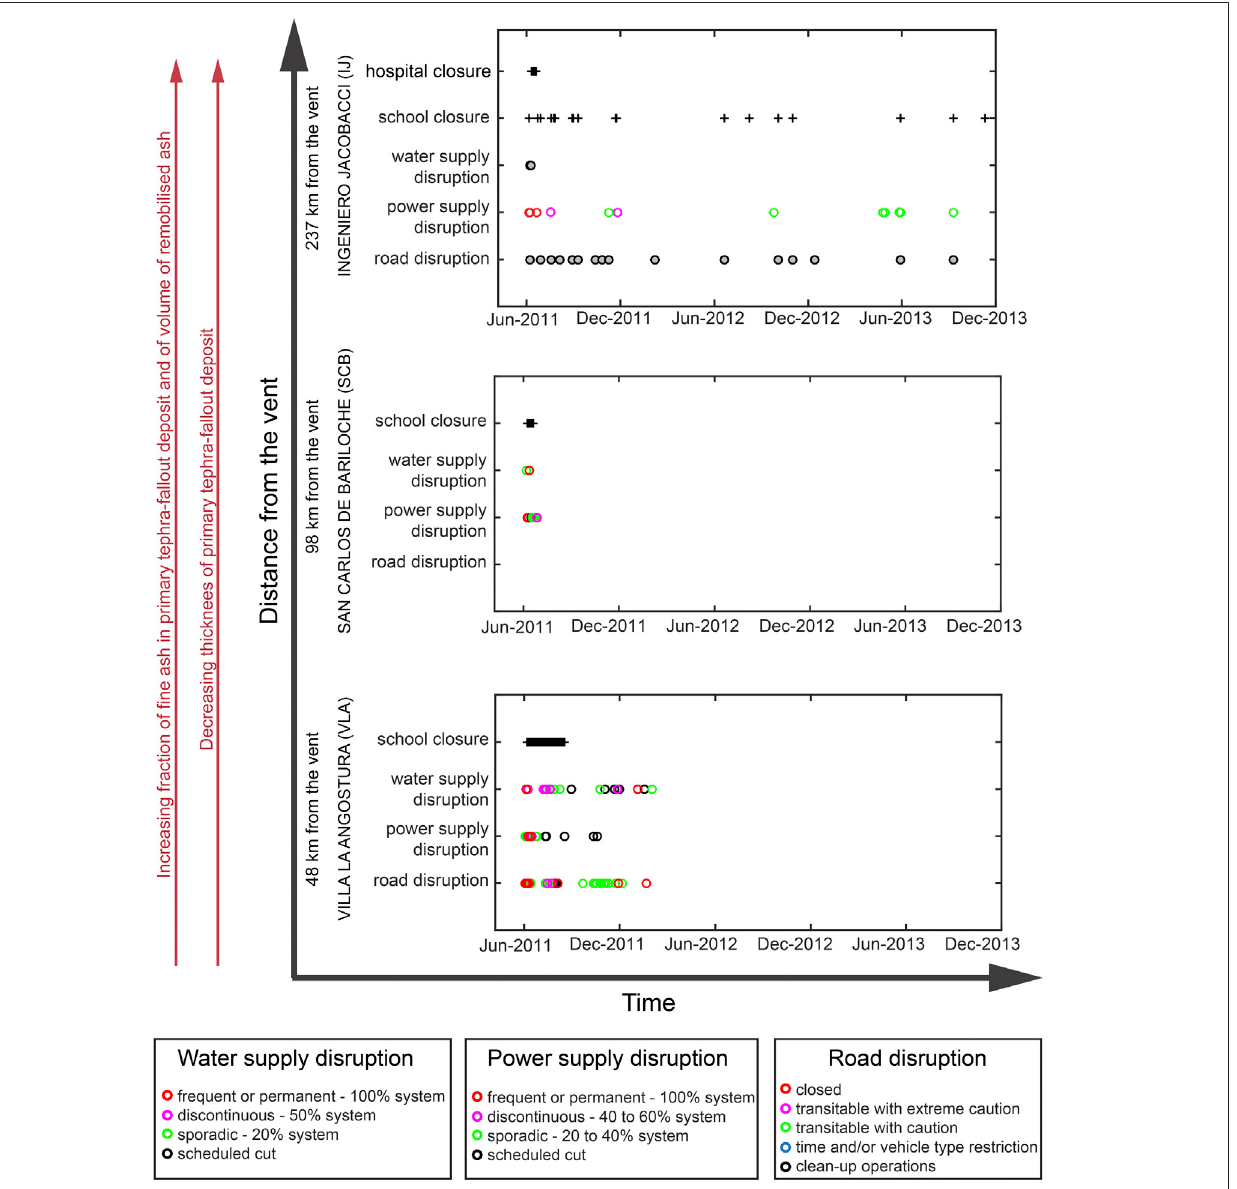
FIGURE 4 | Detailed impact analysis for the three target localities analyzed in this study, VLA, SCB, and IJ. Coloured scales associated with the severity of the impact in terms of frequency and percentage of affected area (water and power supply disruption); and in terms of restrictions (road disruption). Grey circles and black crossesindicatereportofdisruptionbutnoinformationabouttheduration,frequencyorareaaffectedbytheimpact.NodataaboutroaddisruptioninSCBwasavailable. Space and time axis are indicative and not to scale.